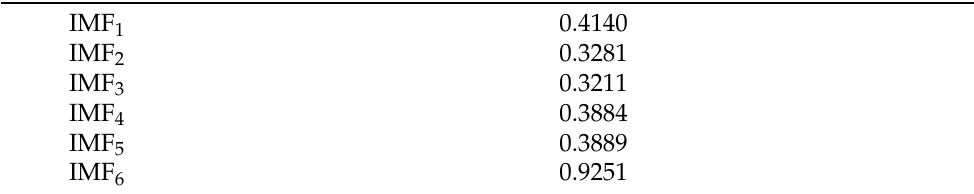
Table 2. Results for the correlation energy fluctuation coefficient calculated by the six IMFs.